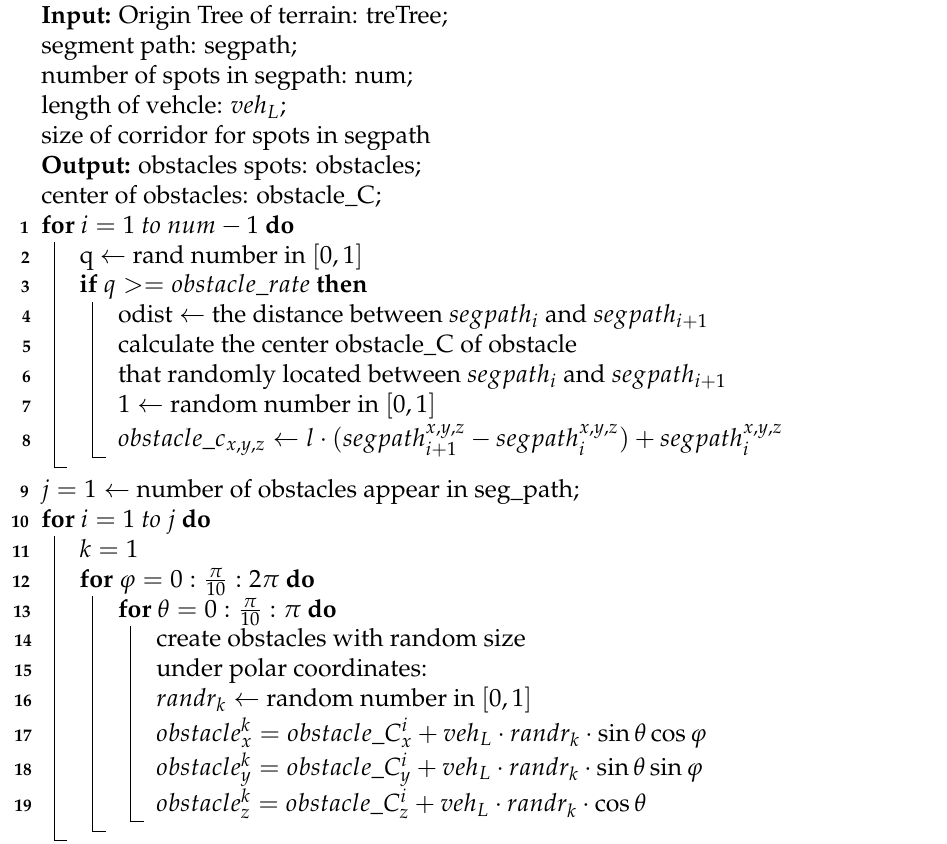
Algorithm 1: Generate the randomly unknown